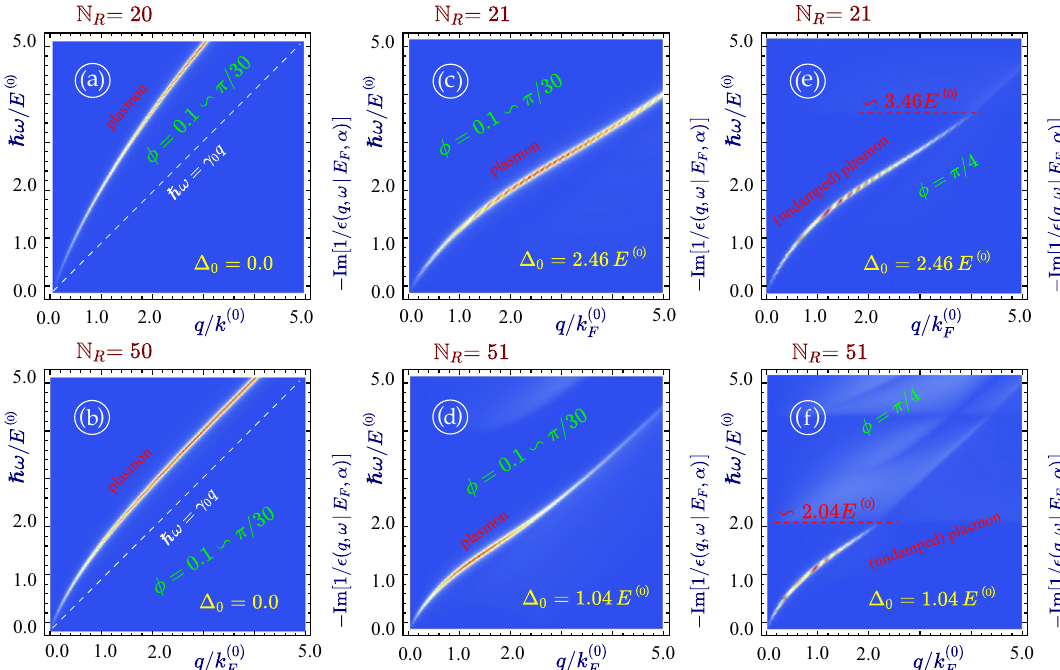
T Figure 5. Plasmon excitations in α 3 nanoribbons. All panels ( a ) through ( d ) display density plots of the − Im 1 /ǫ( q , ω E F , α) E F , α) spectral loss function S ( q y , ω as functions of ω and q y with N R y | = − | and 51. The undamped plasmon excitations correspond to sharp peaks of the loss function (ideally, S (cid:31) (cid:30) therefore, the colorbars were not added to these panels. The values of the material bandgap are determined solely by the width of a nanoribbon and are exactly the same as we have for Fig. 4. The plasmon dispersions in ( a ) and ( b ) are related to metallic electronic spectra ( a ) and ( c ). However, they are to semiconducting ones in all other panels. Parameter α was chosen as π/ 4 (a dice lattice) for the lowest panels ( e ) and ( f ) but α ∽ φ all the other plots. Panel ( f ) shows the same situation as ( h ) but for a larger (doubled) ranges of q and ω